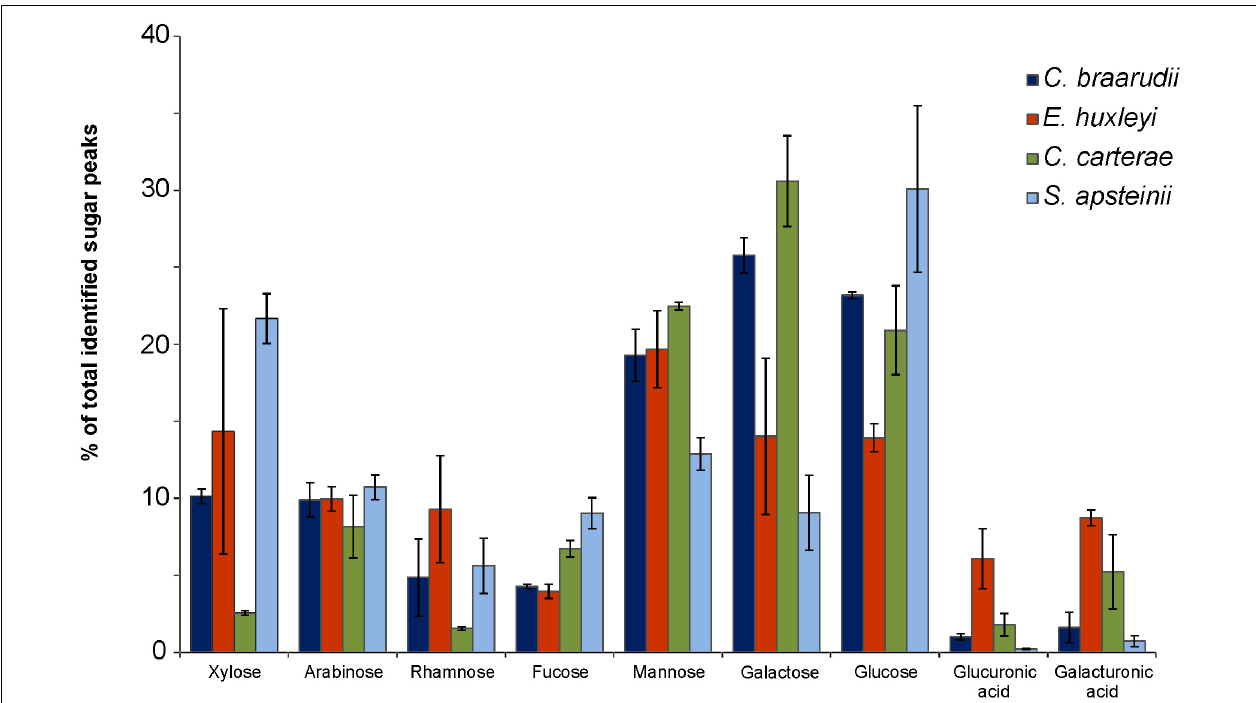
FIGURE 6 | Biochemical composition of coccolith-associated polysaccharides (CAPs). Monosaccharides and uronic acids released by acid hydrolysis of 0.1 M EDTA insoluble polysaccharides extracted from purified coccolith fractions from four coccolithophore species ( C. braarudii, E. huxleyi, C. carterae, S. apsteinii ). Data are presented as the proportion of total identified residues following GC–MS analysis of trimethylsilyl derivatives. n = 3. Error bars represent standard